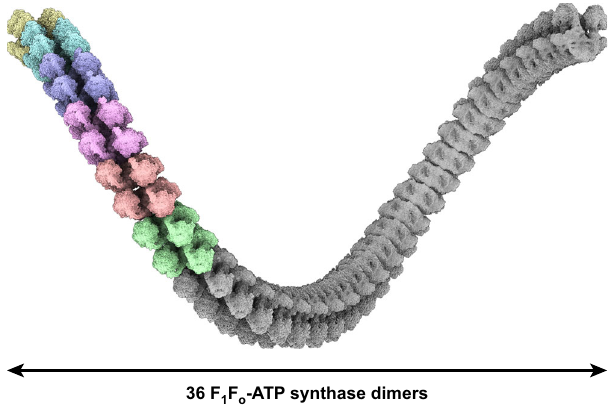
Fig. 8 Helical row model of type III ATP synthase extrapolated from the single-particle reconstruction. Six copies of ATP synthase tetramer (colored densities) arranged by superposition according to the inherent architecture (using a bridging tetramer map, not shown) results in a row with right-handed helical twist. Two-fold propagation of the six ATP synthase tetramer copies (gray colored copies) completes a helical row with 36 ATP synthase dimers in one helical